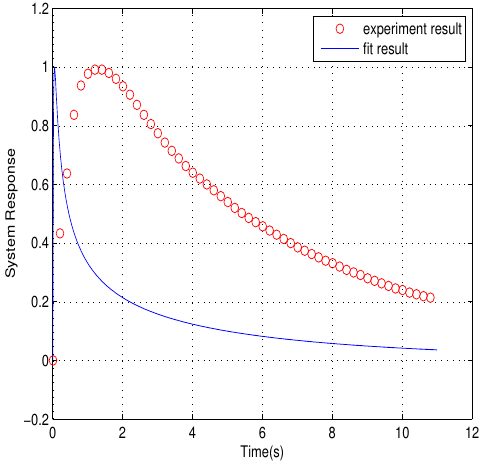
Figure 5: Comparison of the experimental data and theoretical models